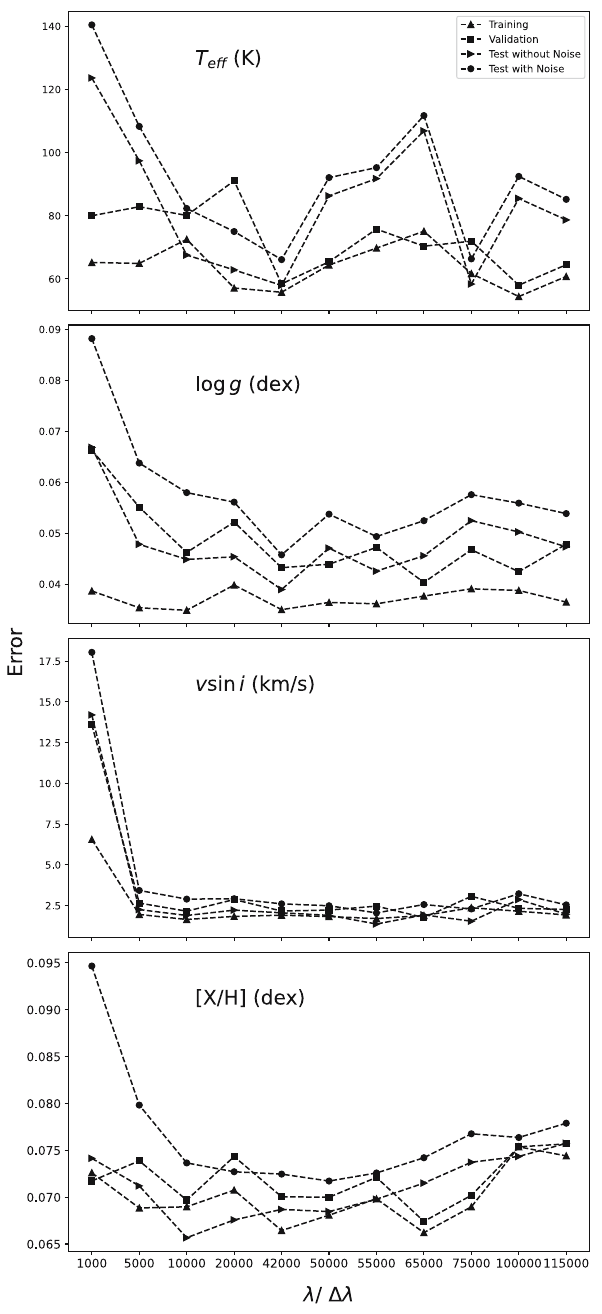
Figure 3: Derived accuracy for T eff , g log , [ ] / M H , and v i sin e as a function of the resolving power. We present the accuracy values for the training data ( triangles ) , the validation data ( squares ) , the test data ( triangles tilted right ) , and the noisy test data ( circles )